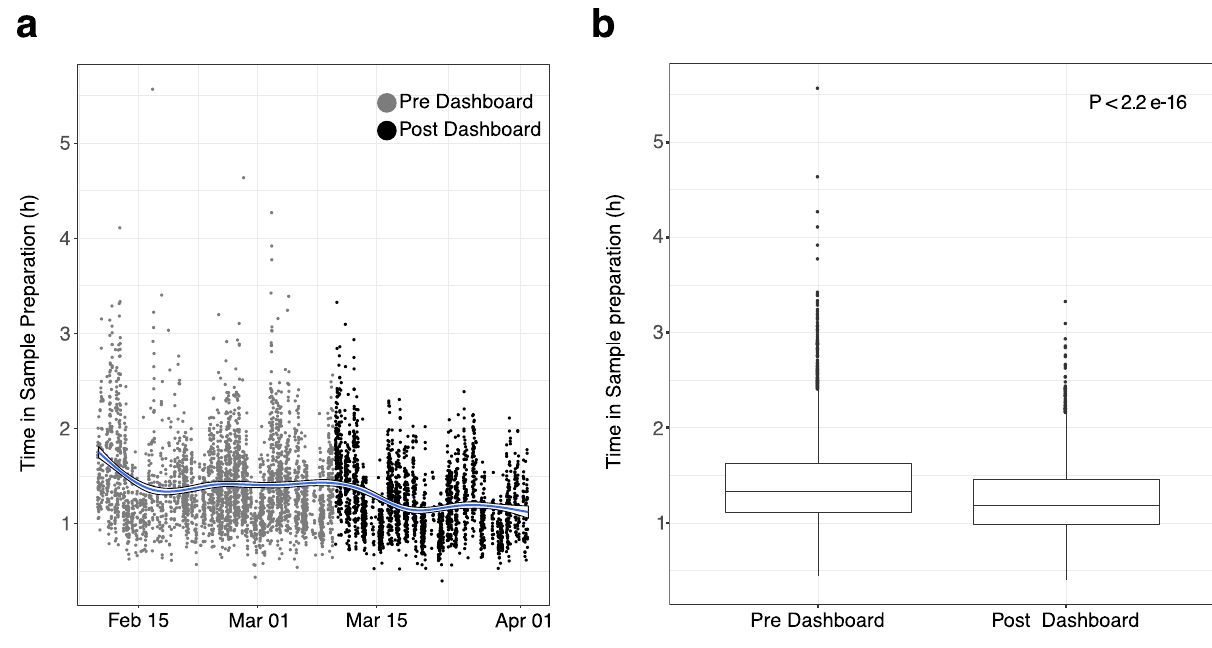
Figure 3. Using informatics dashboards to improve process efficiency in Sample Preparation. ( a ) Each point represents a single microplate where the x axis describes creation time within LIMS and y axis the total time spent within the Sample Preparation step. Grey points are before the introduction of the in-lab dashboard; Black points are post introduction. Blue line is a regression calculated using a generalized additive model with the SE shown. ( b ) Box plot of data from ( a ). P value from Wilcox test. Figure prepared using R with ggplot2 v 3.3.2 [CRAN—Package ggplot2